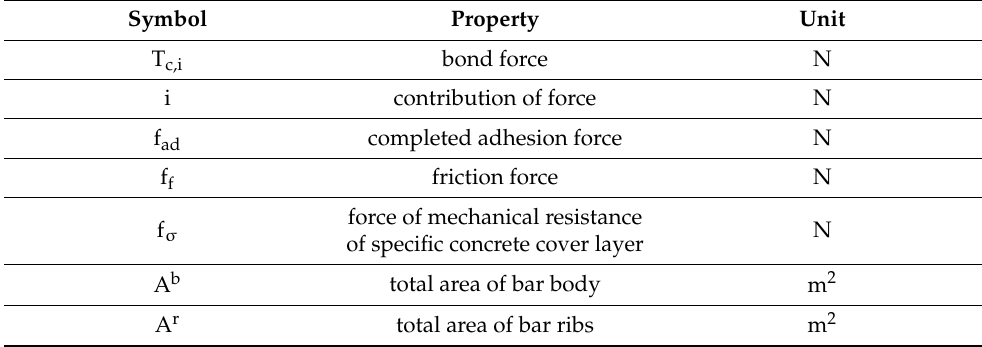
Table 7. Description of individual variables from Equation